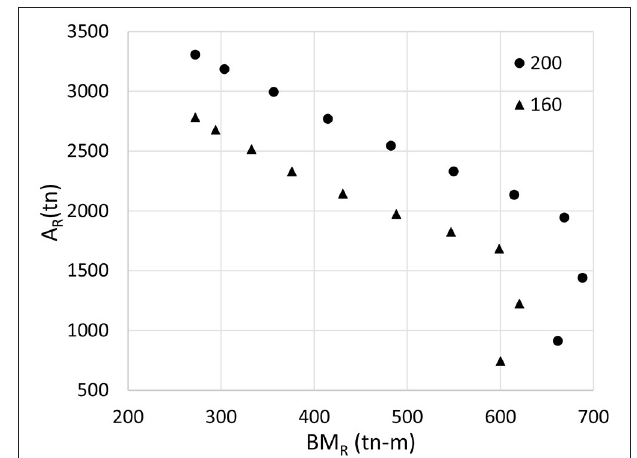
FIGURE 4 | Typical pier of the bridge.